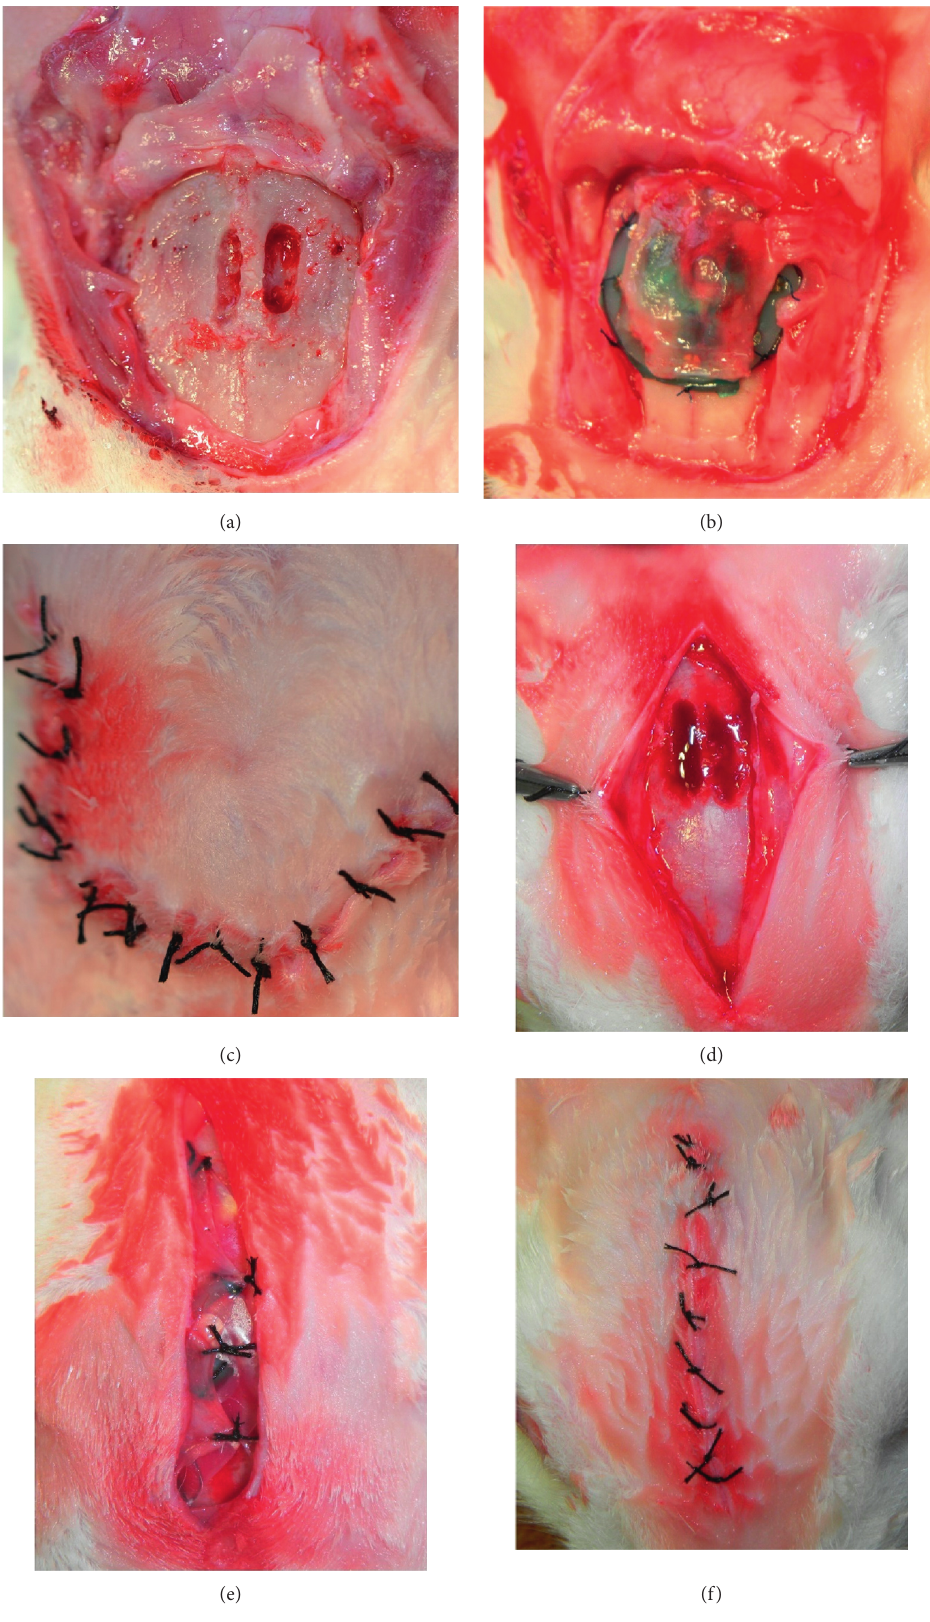
Figure 2: Images of the surgical procedures. For the expansible guided bone regeneration (EGBR) device, (a) periosteal and skin U-shaped flaps are reflected and the cortical groove is created. (b) The EGBR device is fixed over the calvarium and covered by the periosteum. (c) The skin flap is sutured back in place. For the smart guided bone regeneration (SGBR) device, (d) the midline incision is made, skin and periosteal flaps are reflected, and the cortical groove is created. (e) The SGBR device is fixed over the calvarium and covered by the periosteum. (f) The skin flap is sutured back in